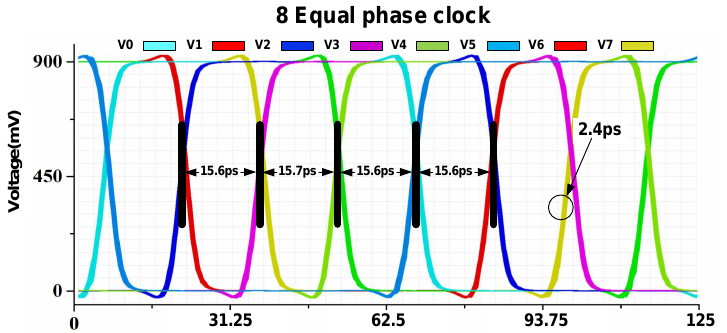
Figure 24. Eight equal phase clocks.